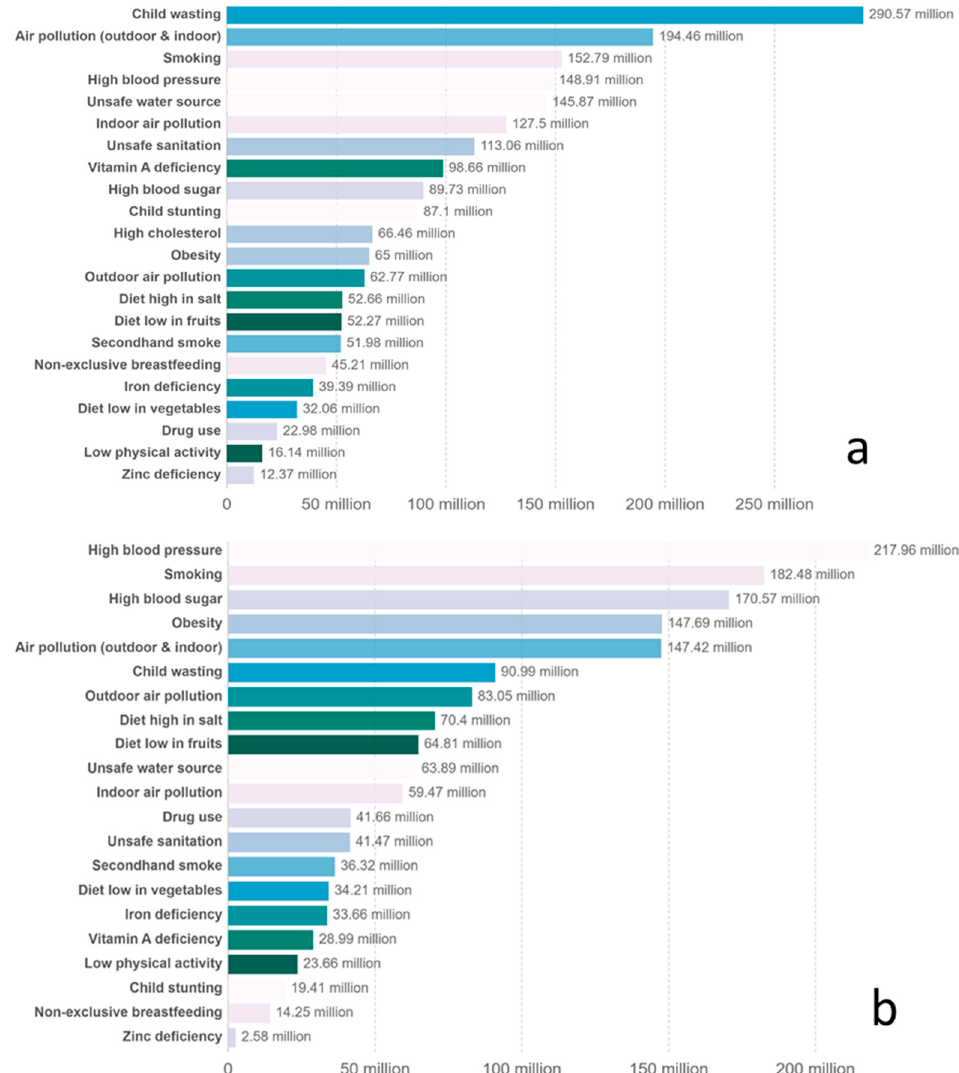
Figure A4. Disease burden by risk factor. ( a ) Data for the worldwide population in 1991. ( b ) Data for the worldwide population in 2017. The disease burden is measured as disability-adjusted life years (DALYs). One DALY is the equivalent of losing one year of good health because of either disability or premature mortality. One DALY represents one lost year of healthy life. Information provided by Institute for Health Metrics and Evaluation [45].